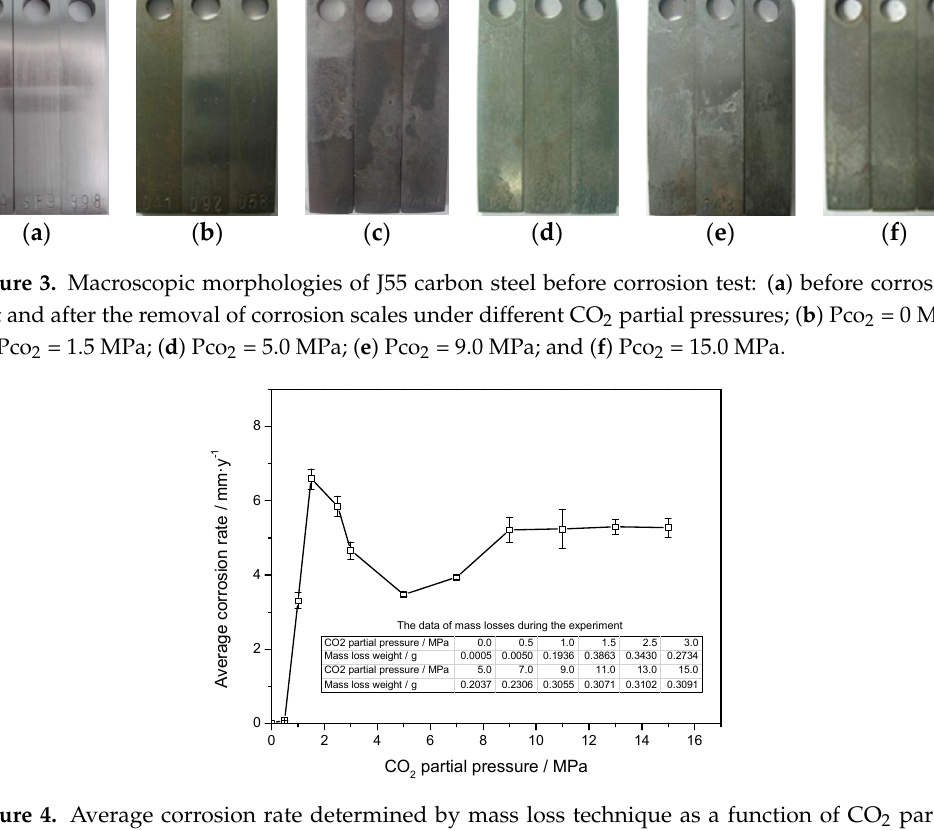
Figure 4. Average corrosion rate determined by mass loss technique as a function of CO 2 partial pressure for steel immersed in 30% crude oil/brine mixtures.